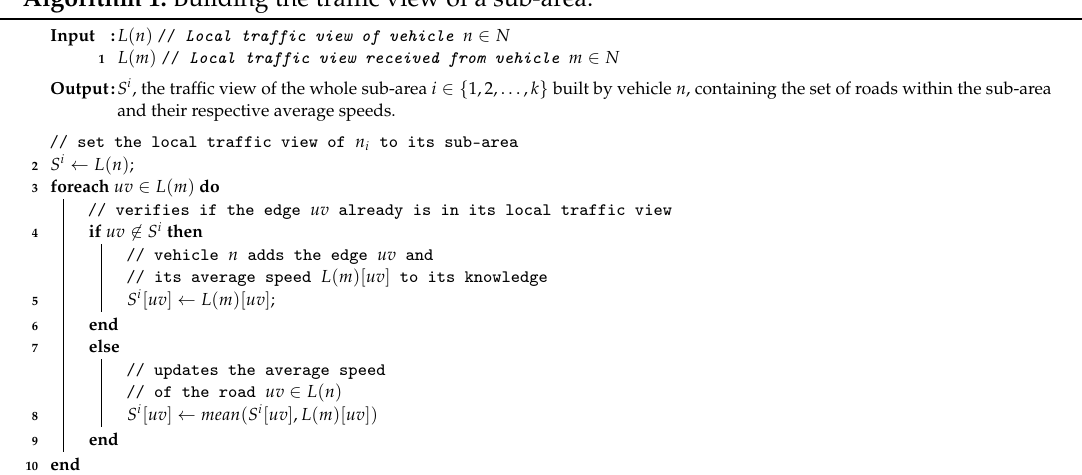
Algorithm 1: Building the traffic view of a